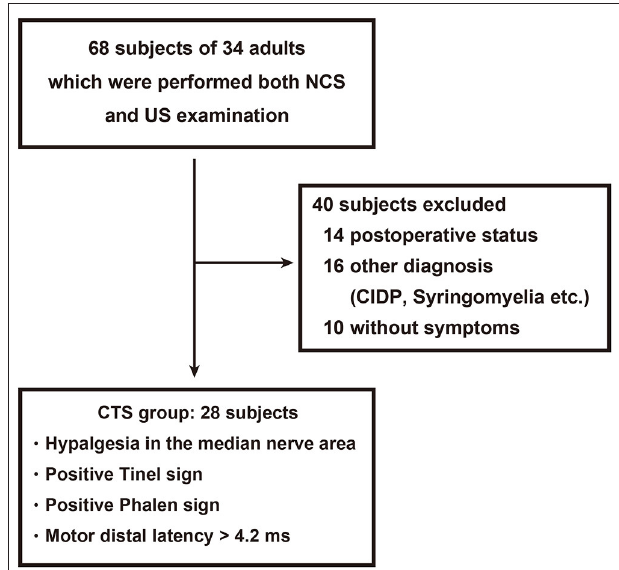
FIGURE 1 | Patient flow diagram. A total of 28 hands from 21 patients with carpal tunnel syndrome (CTS) were enrolled from 68 hands that received both a nerve conduction study and